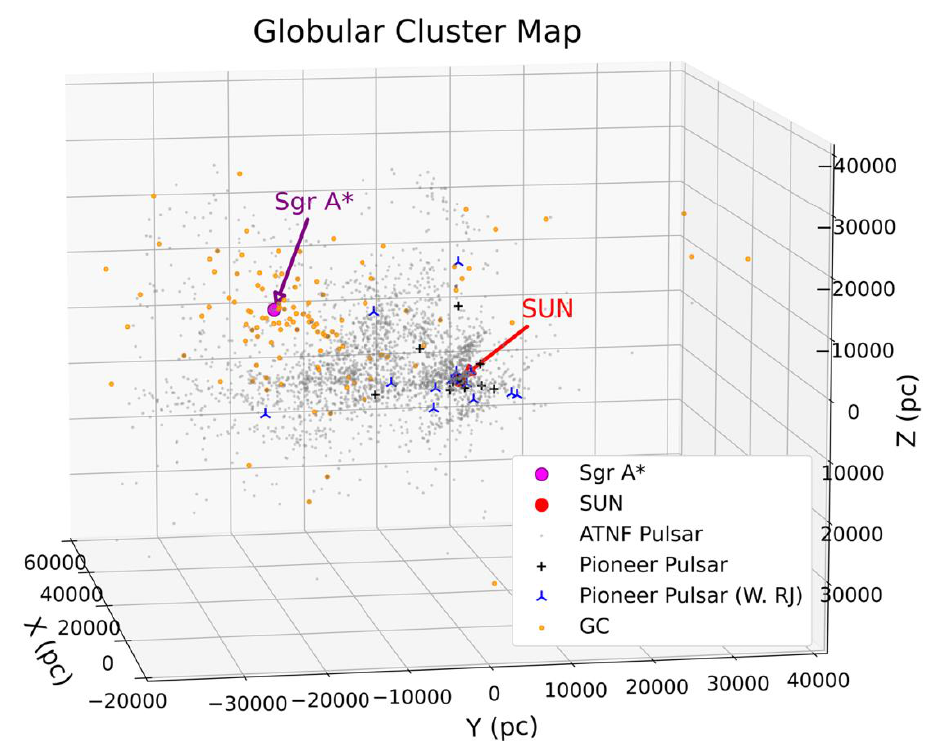
Figure 1. The blue point indicating Sgr A* represents the Milky Way’s center. The red point is the Sun, to show our position in the galaxy. The dark gray points are the known globular clusters from https://heasarc.gsfc.nasa.gov/W3Browse/all/globclust.html (last accessed on 23 March 2022) by Harris (1996) [18]. The purple and orange points are known pulsars obtained from http://www.johnstonsarchive.net/astro/pulsarmap.html (last accessed on 23 March 2022), purple points are translated from the Pioneer plaque picture and the orange points are the corresponding pulsars from the ATNF database. The silver points are additional pulsars that have been discovered, these from the ATNF database.